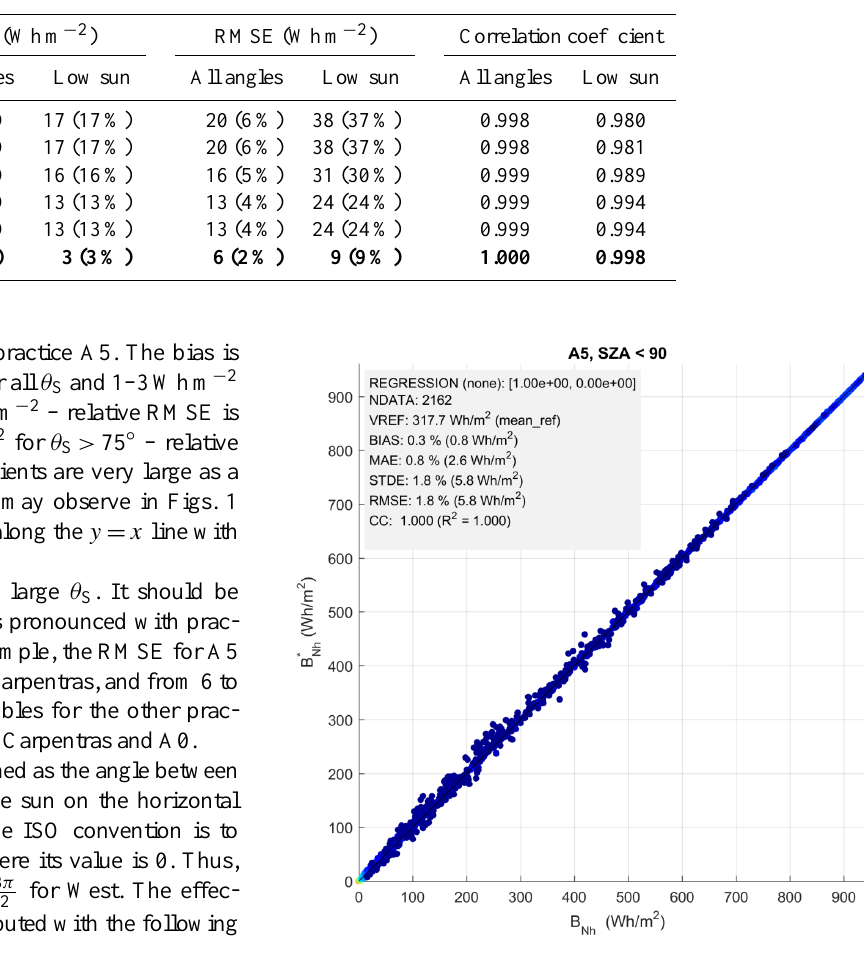
Table 3. Performance of each practice for Payerne for all angles and the subset “low sun”. Relative values are computed relative to the mean value of B Nh . Best results are in bold.